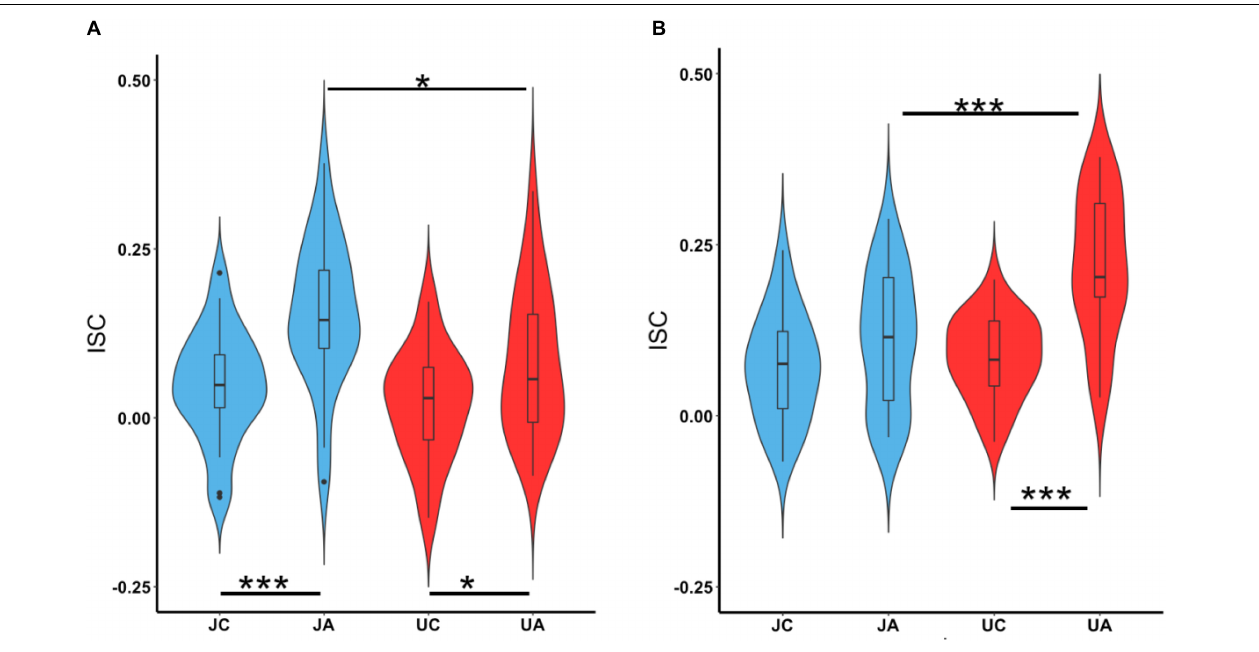
FIGURE 6 | vmPFC and lOFC ISC during character and action segments. The boxplots show the mean and the standard deviation. (A) The ISC in vmPFC for character and action segments for both justified and unjustified movie violence. (B) The ISC in lOFC for character and action segments for both justified and unjustified movie violence. (JC, justified character, JA, justified action, UC, unjustified character, UA, unjustified action, ∗ p < 0.05, ∗∗∗ p <